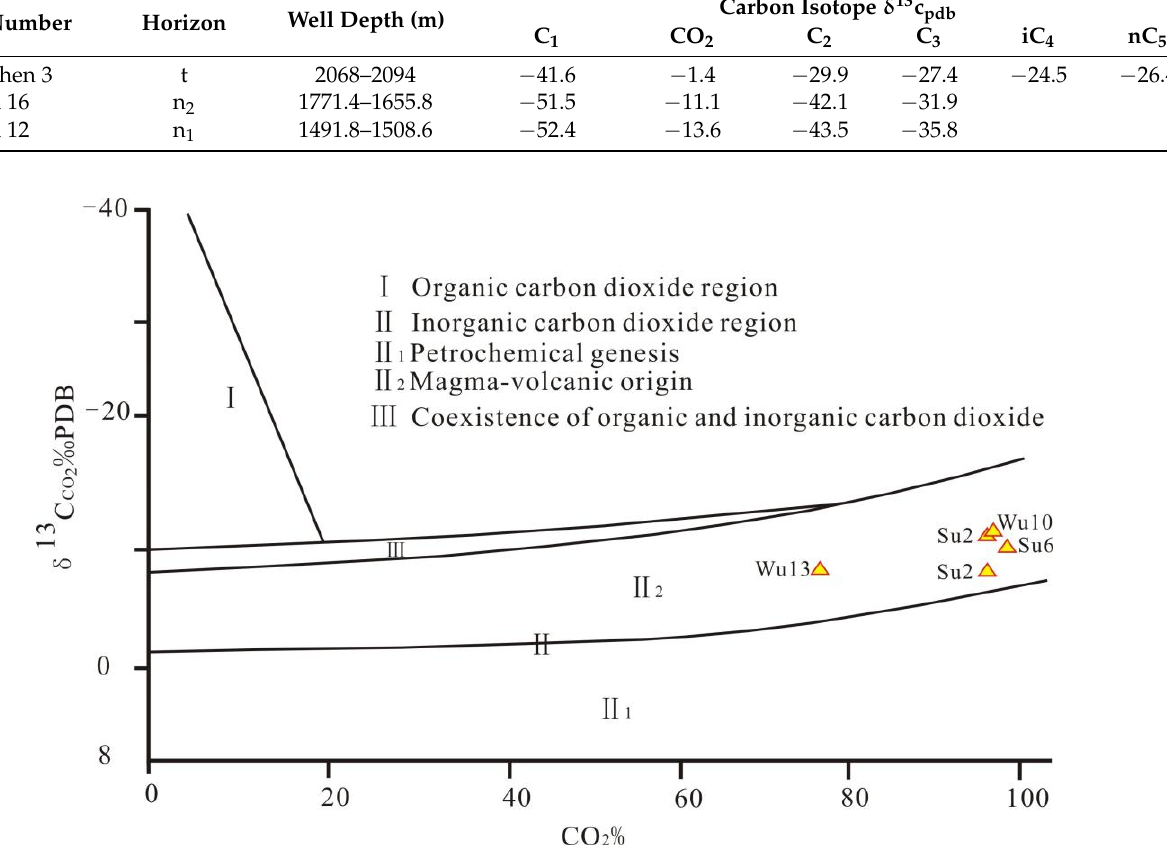
Figure 2. The discrimination map of CO 2 reservoir in Wuerxun depression of Hailar Basin.